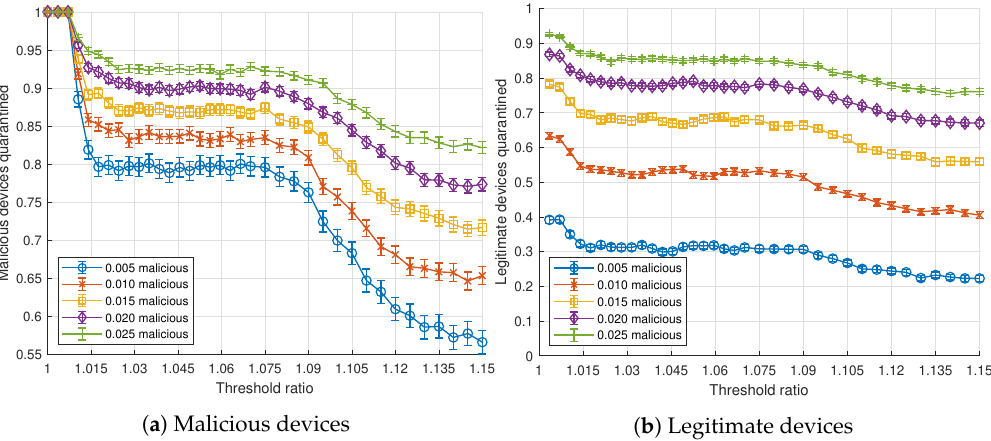
Figure 4. Ratio of devices quarantined as a function of the detection threshold ratio, t r ( n = 100, s p = 1s, f m = 100) for p m ∈ { 0.005,0.010,0.015,0.020,0.025 } .